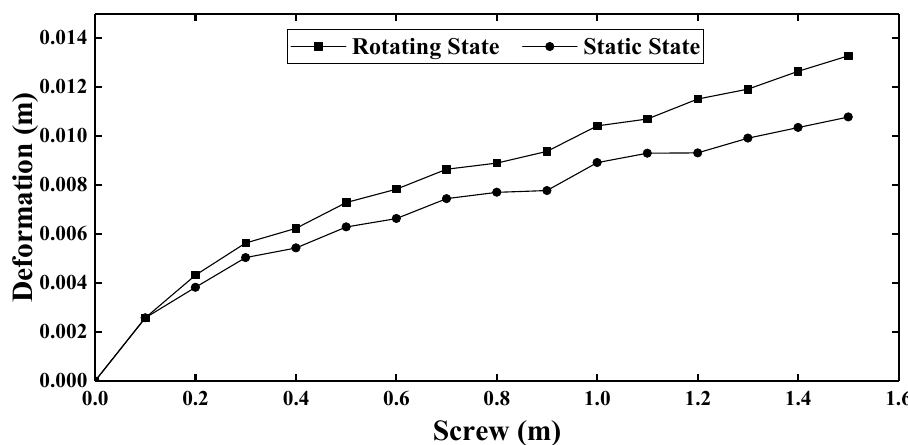
Figure 14. The radial deformation of the lead screw with a support slider.